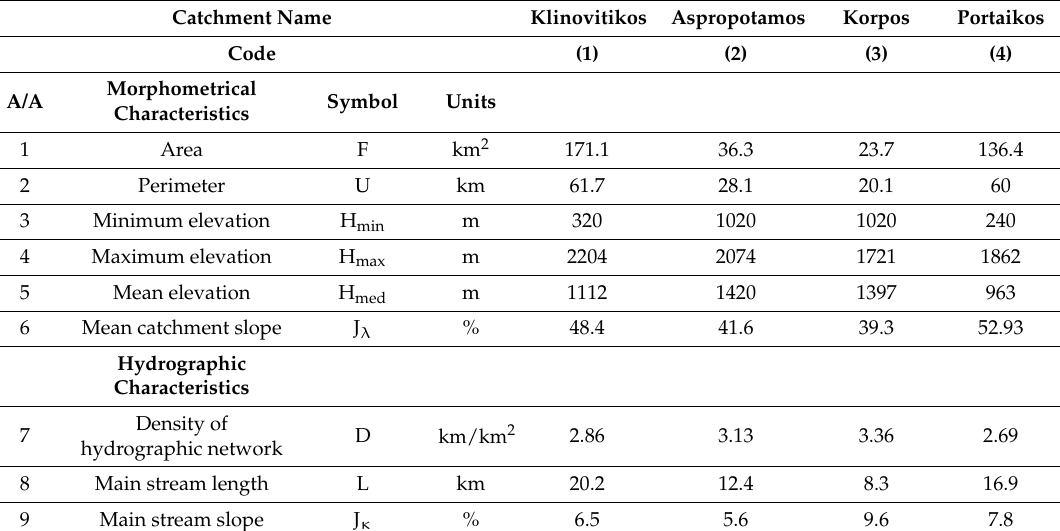
Table 2. Morphometrical and hydrographical characteristics of the mountainous